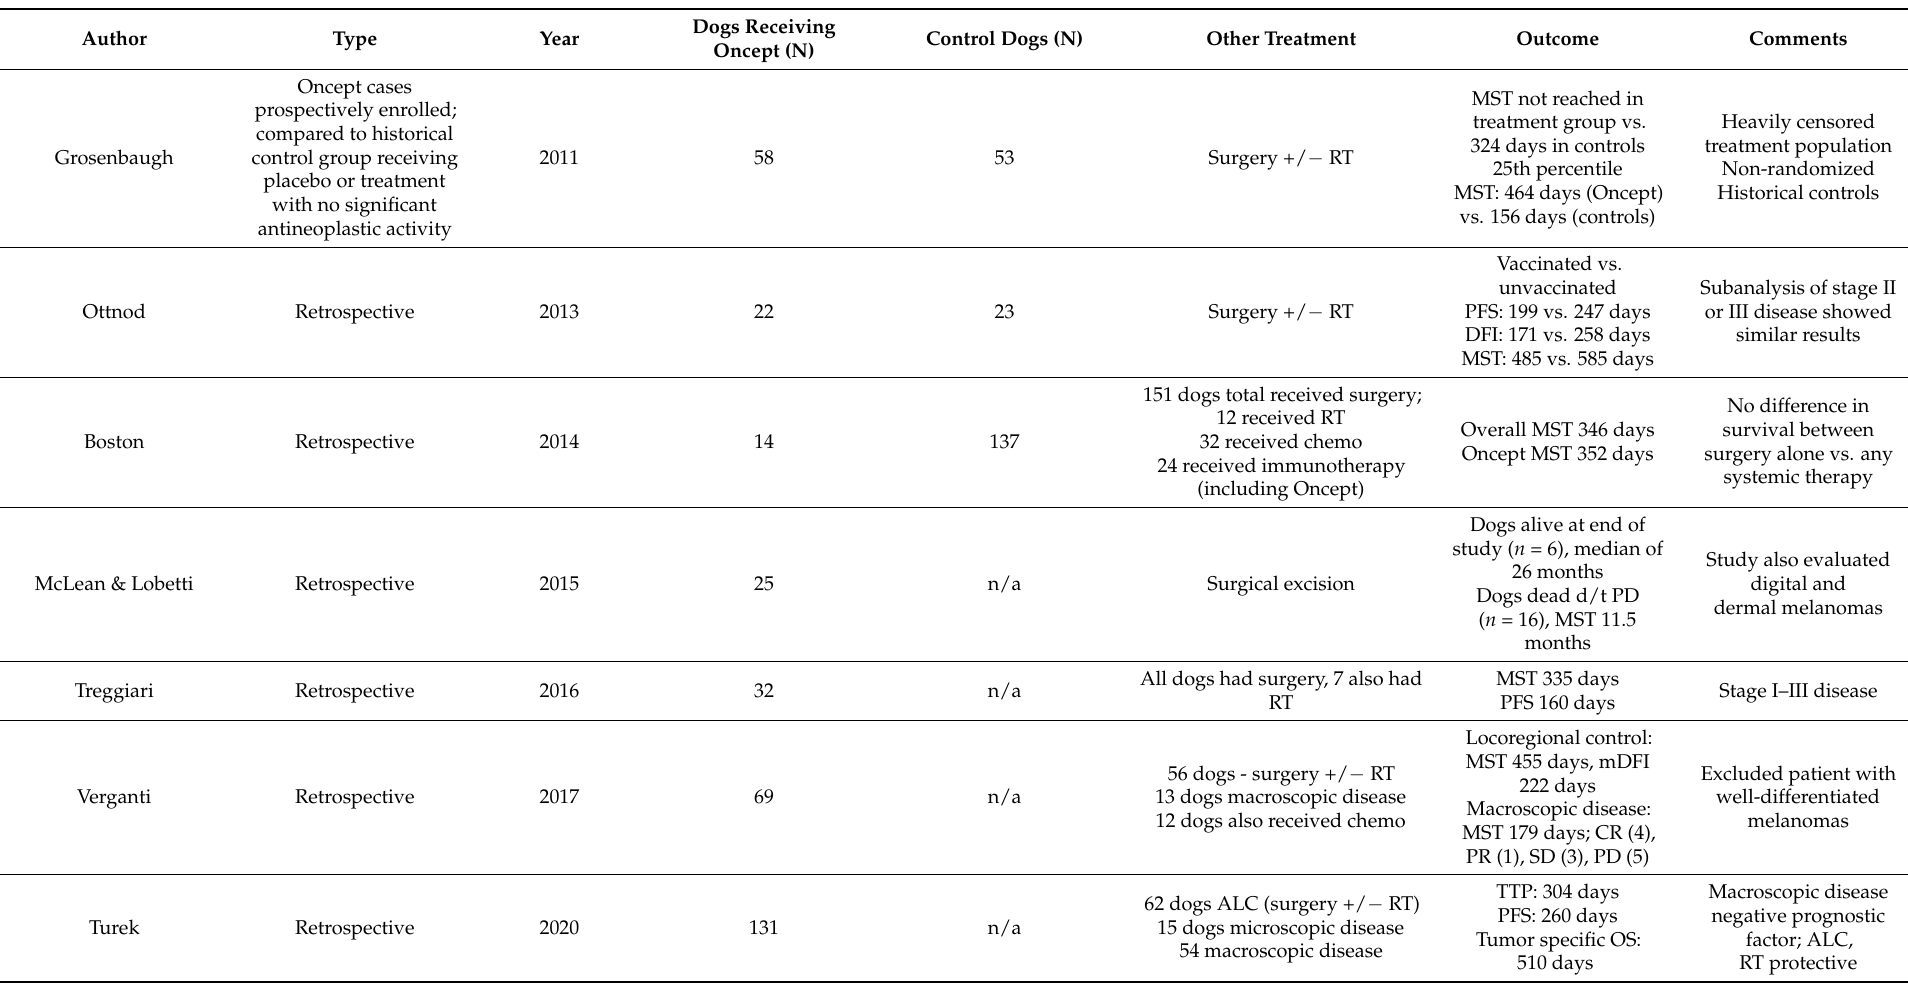
Table 1. Summary of published studies evaluating the use of Oncept in canine patients with oral melanoma. Abbreviations: RT = radiation therapy, MST =